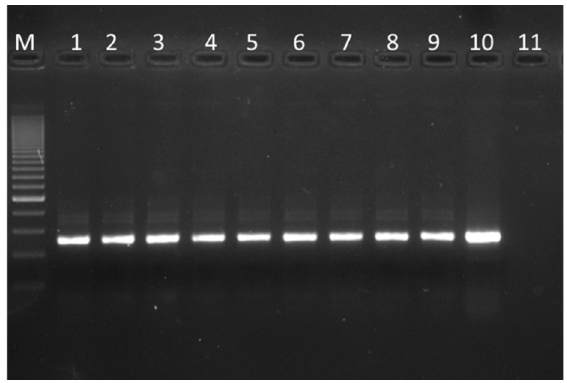
Figure 3. Specific PCR assay for L. crispatus 16S rRNA; total DNA extraction from powders. Within the figure: Marker 200 bp (M); LMG 9479- L. crispatus type strain (1); Product A (2); Product B (3); Product C (4); Product D (5); Product E, MD (6); Product F (7); Product G (8); Product H (9); Product I, MD (10); negative template control (11).